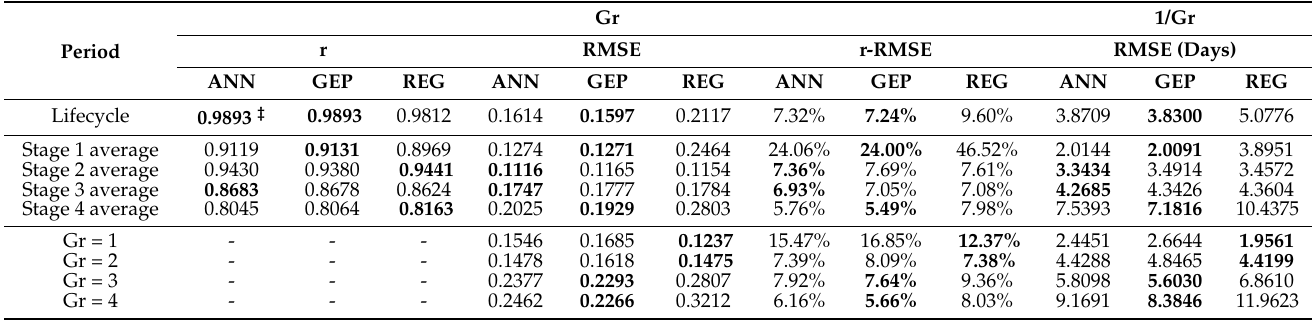
Table 3. Modeling results for the whole growth period by three models in the lifecycle, stage average, and specific key stages.